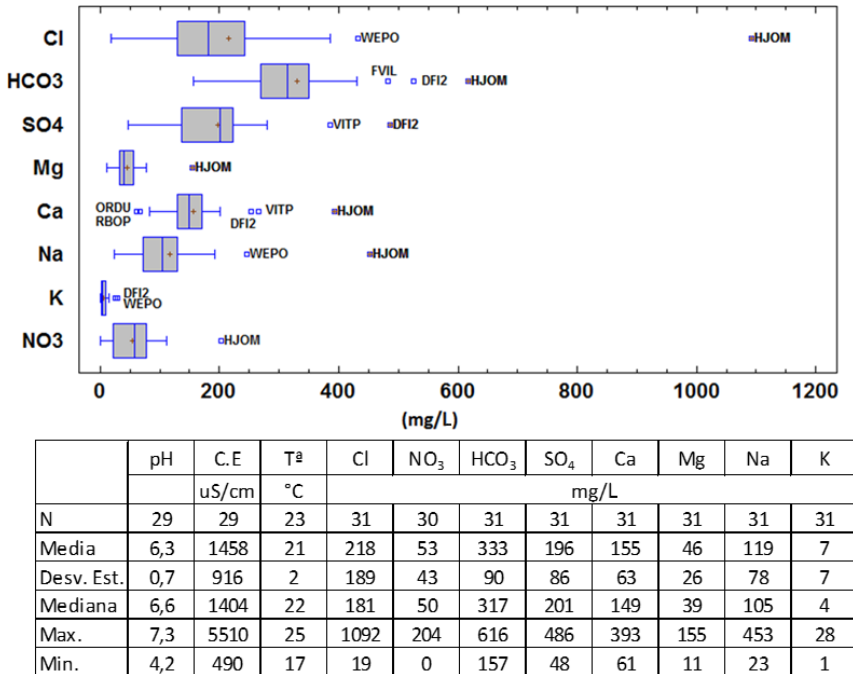
Figure 3. Box-and-whisker diagram of major ions and descriptive statistics.